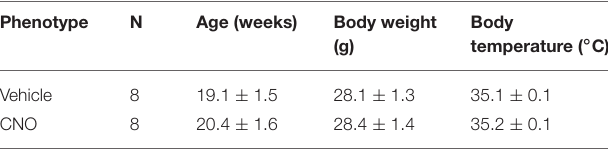
TABLE 1 | Basic characteristics of C57BL/6J mice, which underwent sleep studies after vehicle (saline) and clozapine-N-oxide (CNO)